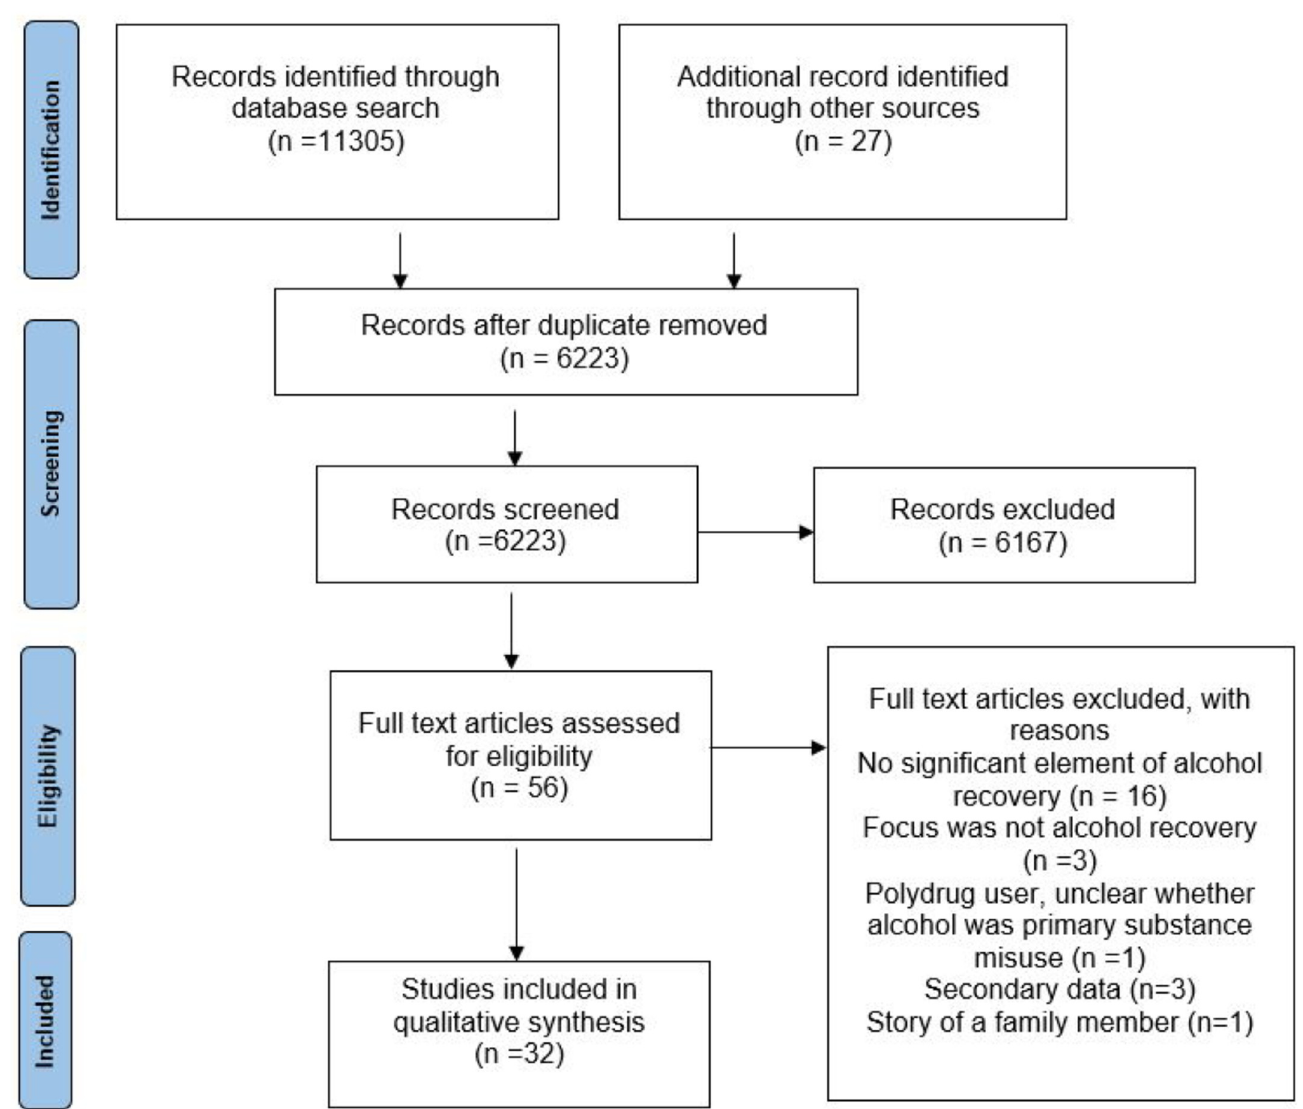
Fig 1. PRISMA flow diagram for studies